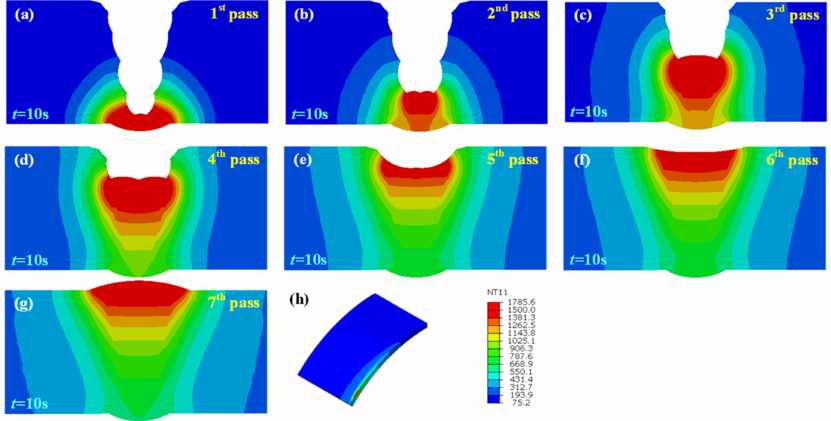
Figure 8. Joint temperature field with 1 mm butt gap: ( a – g ) temperature distribution of each pass, ( h ) isometric view of temperature field.